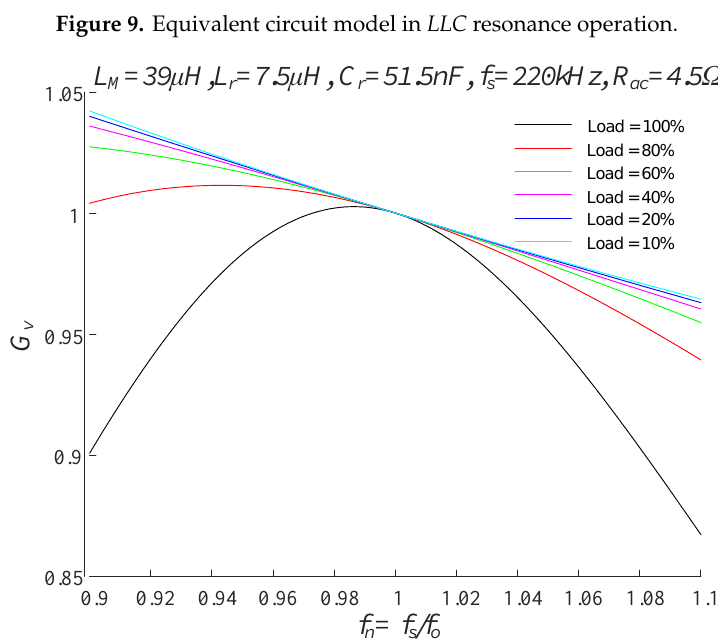
Figure 10. Equivalent circuit model in LC resonance operation.